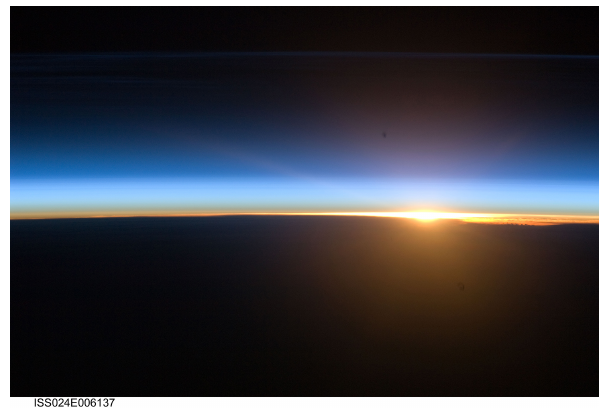
Figure 1. The Earth’s limb as seen from the International Space Station on 16 June 2010. The ISS nadir point is in the Aegean Sea at 36.8 ◦ N latitude and 27.1 ◦ E longitude. Image courtesy of the Im- age Science & Analysis Laboratory, NASA Johnson Space Center, Mission-Roll-Frame ISS024-E-6137 (http://eol.jsc.nasa.gov).